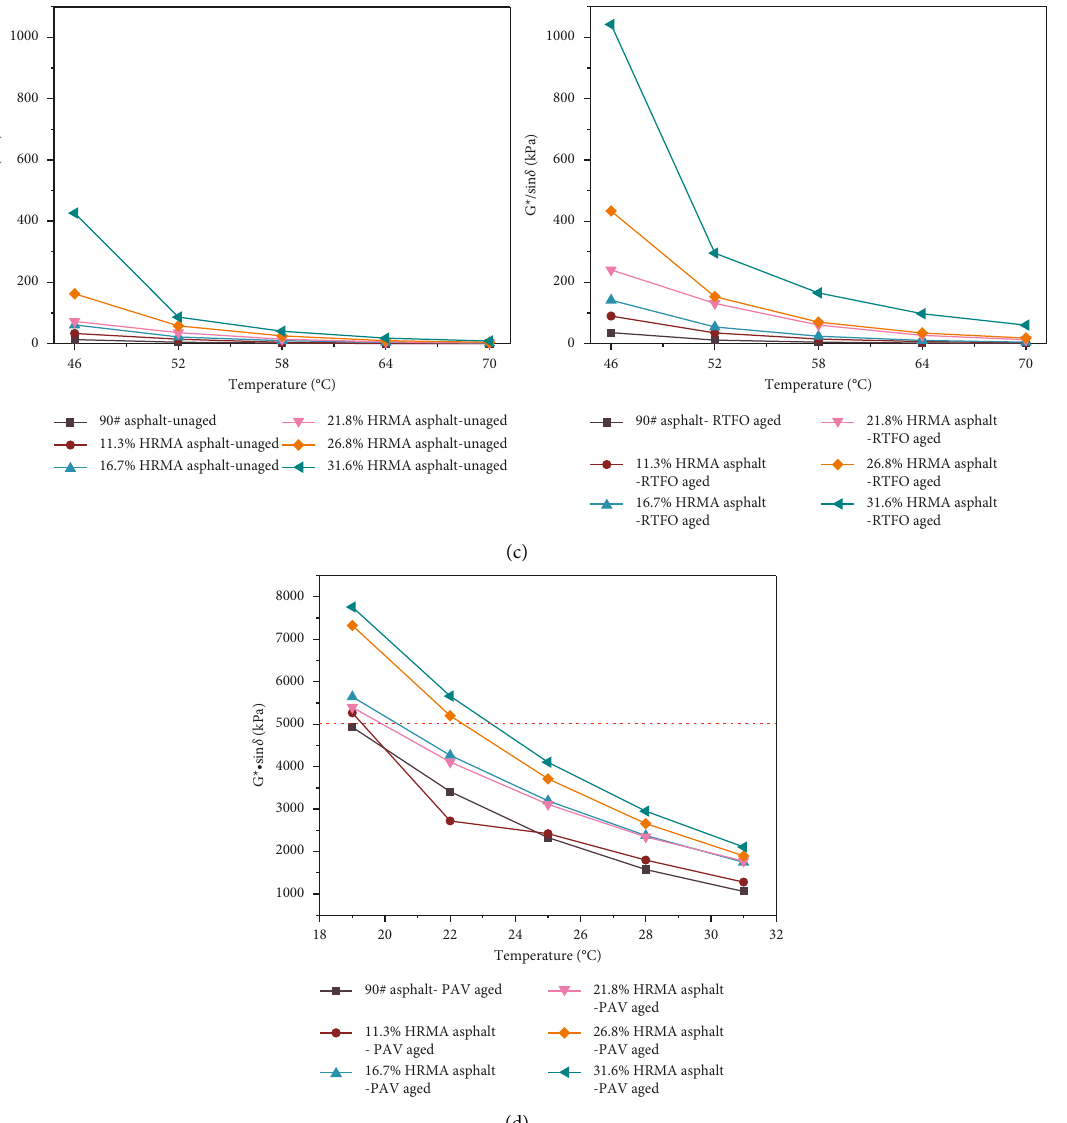
Figure 11: High-temperature rheological properties of different asphalt binders versus temperature: (a) complex shear modulus, (b) phase angle, (c) rutting factor, and (d) fatigue